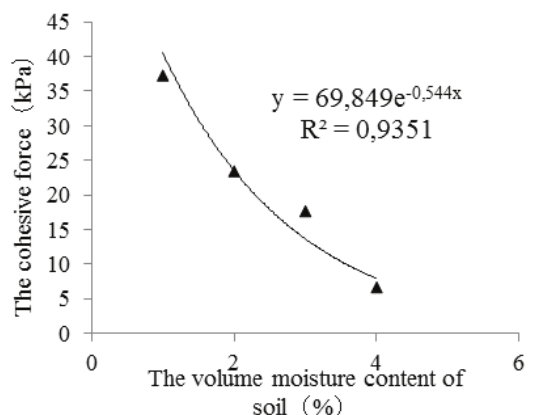
Figure 6: Relationship between friction angle and moisture content of dry red